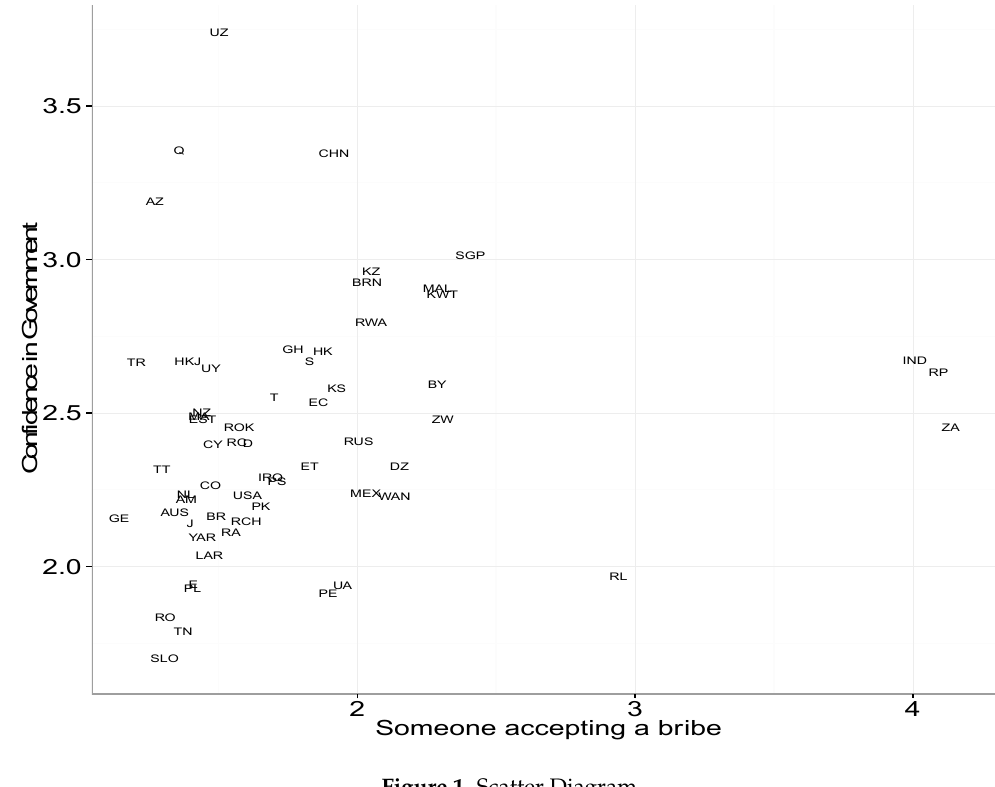
Figure 1. Scatter Diagram.